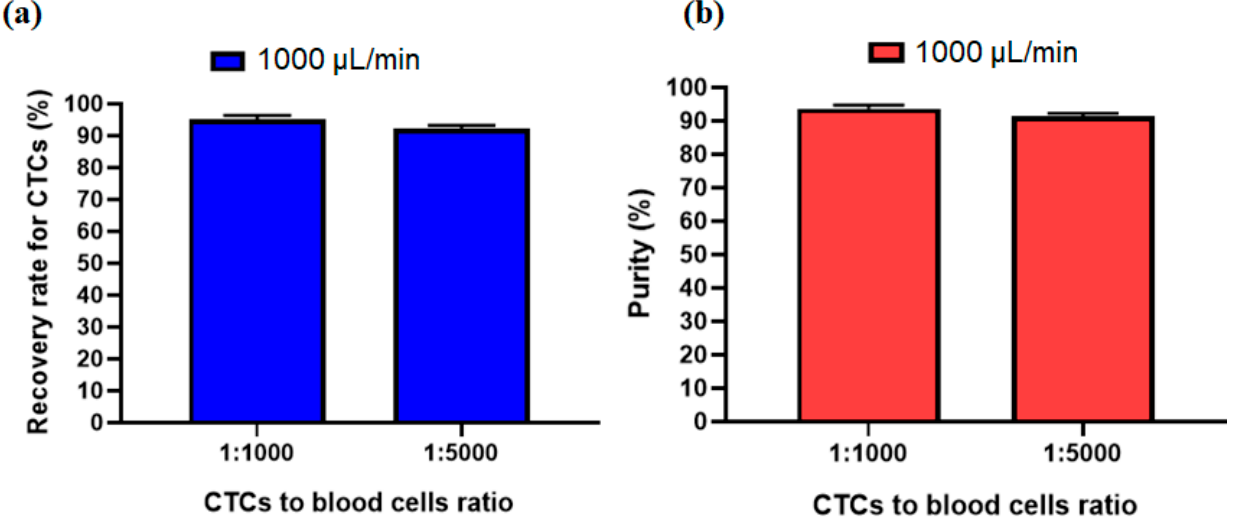
Figure 8. Comparsion of the ( a ) recovery rate and ( b ) purity of separated CTCs at two different ratios of CTC to blood cell numbers .